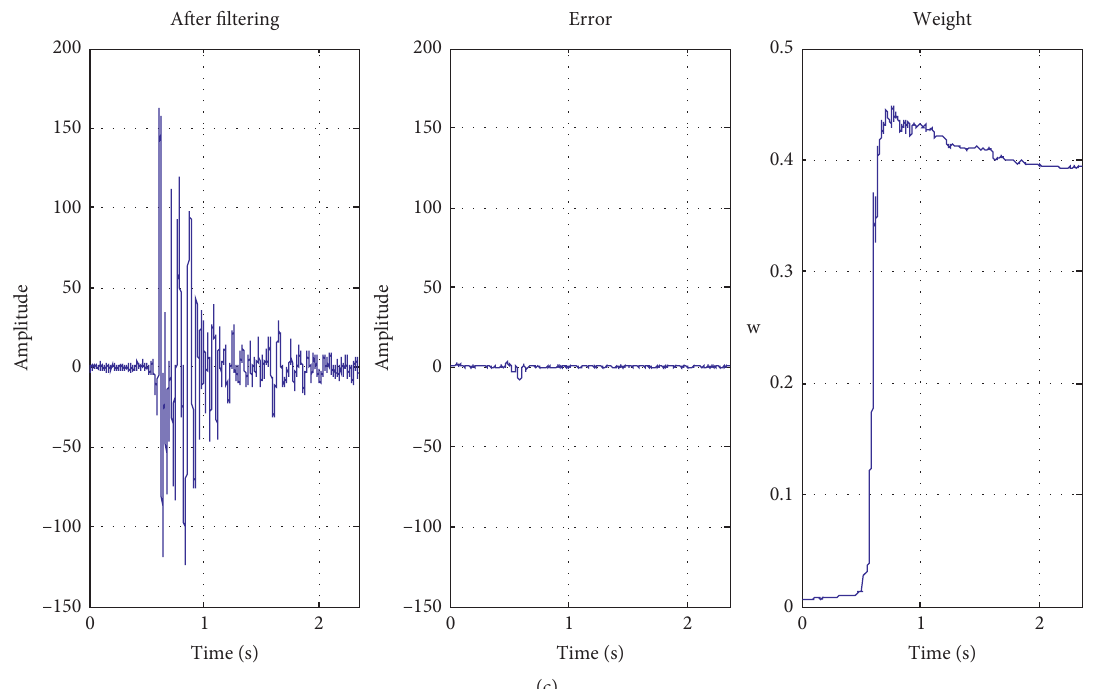
Figure 7: Simulation results of measured signal with different μ values. (a) μ � 1/8 filtering result graph. (b) μ � 1/2 filtering result graph. (c) μ � 2 filtering result graph.